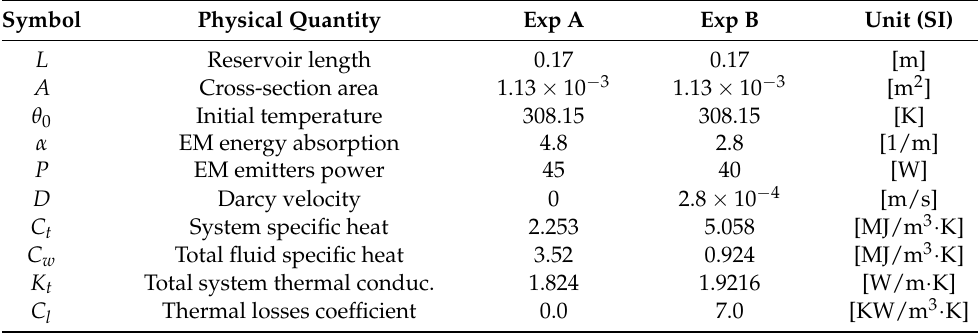
Table A1. Physical parameters used in modeling